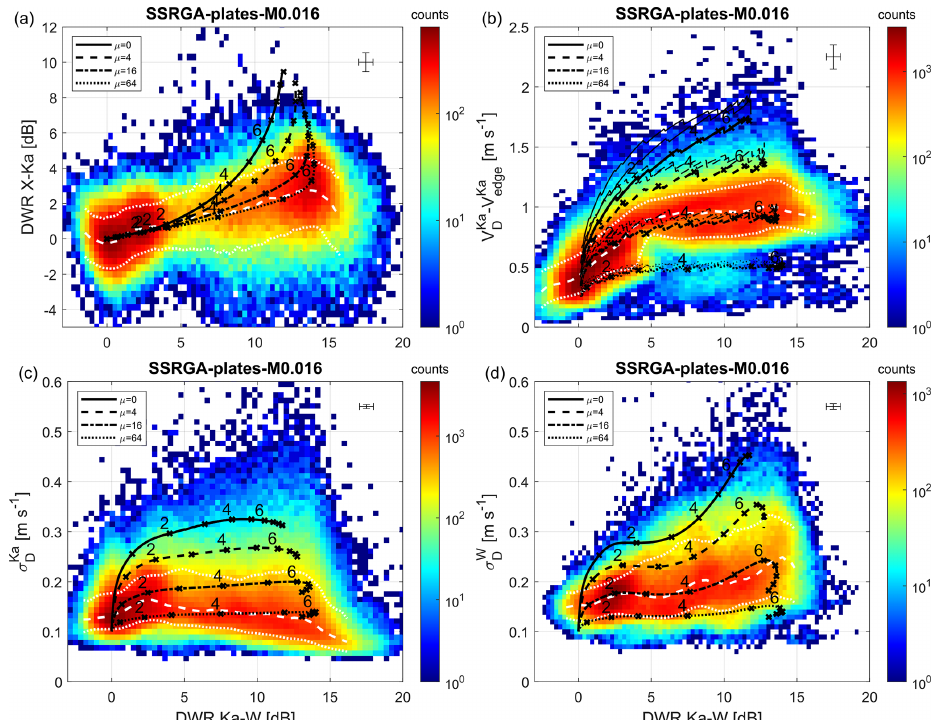
Figure 9. Two-dimensional histograms of observed (a) DWR X , Ka , (b) difference between Ka-band Doppler velocity and Doppler spectra − V Ka slow edge V Ka , (c) Ka-band spectral width σ Ka and (d) W-band spectral width σ W as a function of observed DWR Ka , W . D D D D , slowedge The superimposed dashed white line shows the median and the superimposed dotted white lines show the 10th and 90th percentiles of the histogram for the DWR Ka , W bins containing at least 500 points. The superimposed black lines represent the corresponding parameters forward modeled with the SSRGA for a gamma distribution of aggregates of plates with various µ (see the legends in the plots), a mean mass diameter of 0 < D m ≤ 10mm (each marker corresponding to 1mm step) and a normalized rimed mass M = 0 . 016 (see the text for details). The error bars in the top-right corner of each panel represent the intrinsic measurement uncertainties estimated for high SNRs according to Doviak and Zrnic (2014). In (b) , thick lines correspond to calculations of fall velocities using the Böhm (1992) model, while thin lines correspond to the Khvorostyanov and Curry (2005) and Heymsfield and Westbrook (2010) models. Table 2. Parameters of the main EM-MIC models used in this study: mass–size relation parameters (prefactor a m and exponent b m ),